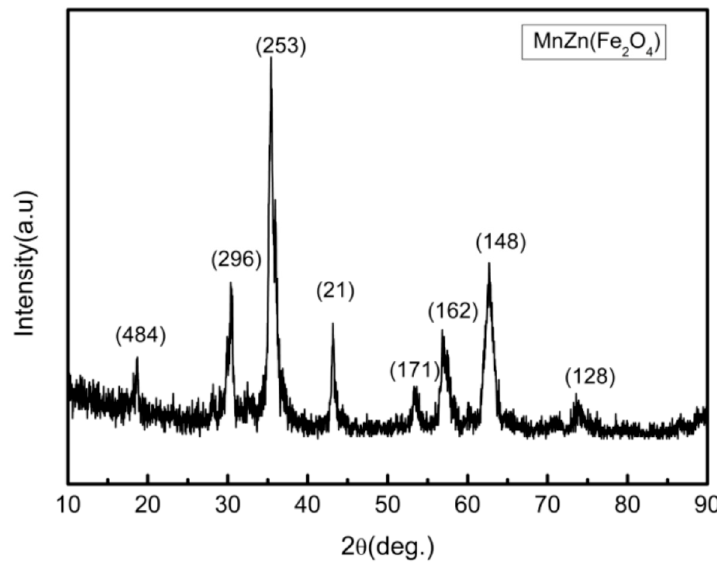
Figure 6. XRD patterns of MnZn (Fe 2 O 4 ) 2 powders.